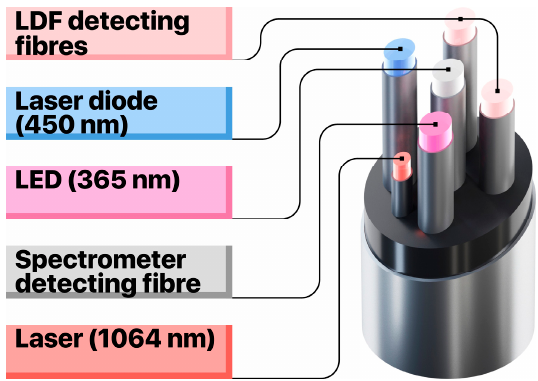
Figure 1. The configuration and measuring channels of the used fibre-optic probe.